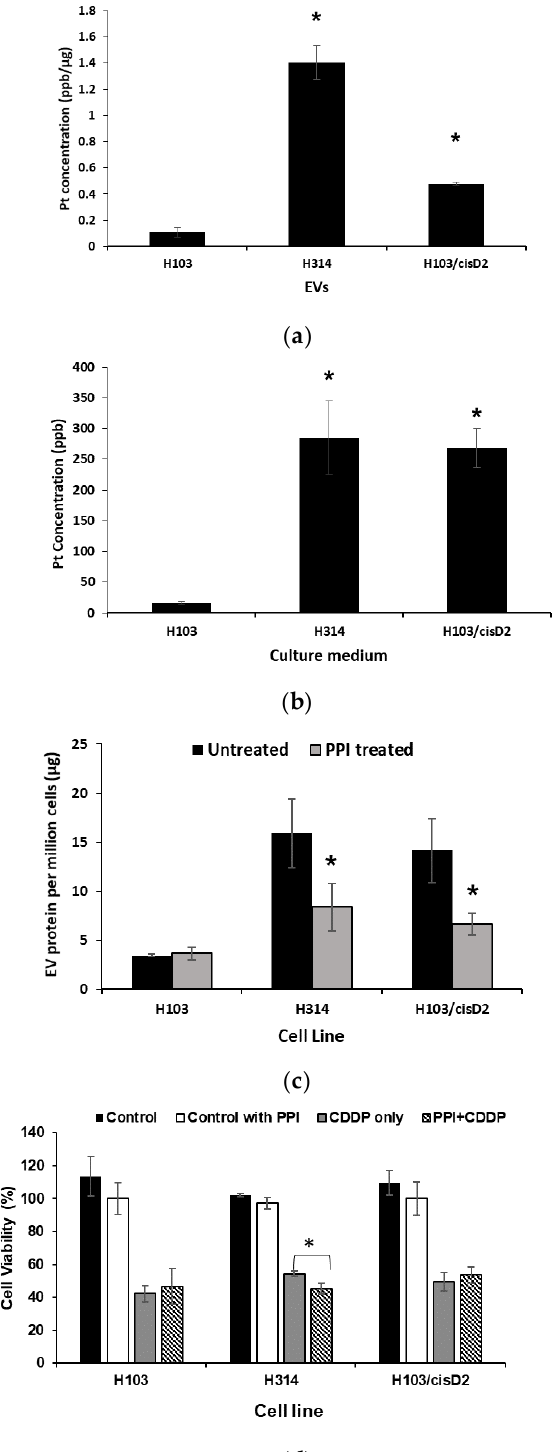
Figure 6. Effect of EV inhibition on drug response of OSCC cells. ( a ) Platinum concentration in EVs derived from OSCC cells. ( b ) Platinum concentration in culture medium after removal of EVs. ( c ) Inhibition of EVs produced by OSCC cell lines using PPI. ( d ) Effect of PPI treatment on cisplatin sensitivity of OSCC cells. * Indicates significant difference, p < 0.05, n = 3 (Student’s t -test, Tukey’s post-hoc).